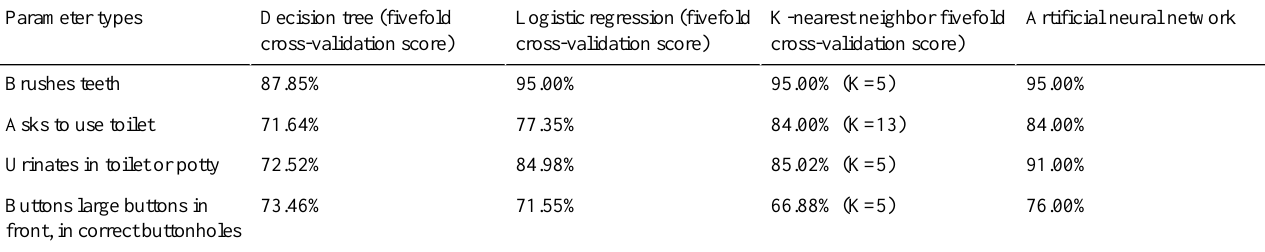
Table 5. Summary of the accuracy of all prediction models based on demography for "daily living skills." score)Parameter types